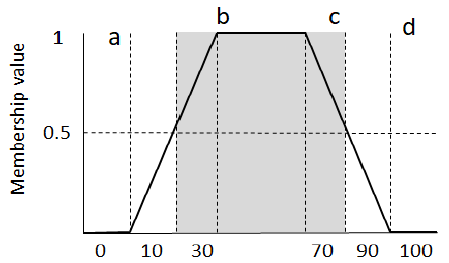
Figure 1. Linear membership function (source: [12]).